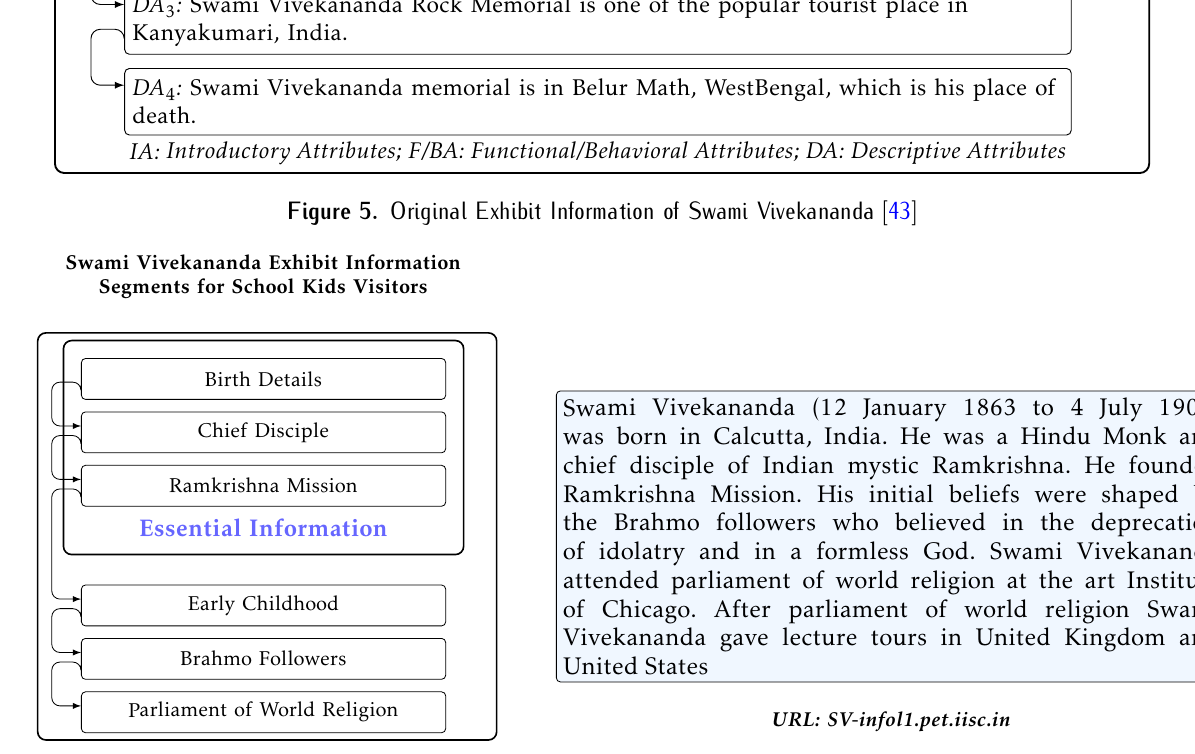
Figure 6. Organized Exhibit Information of Swami Vivekananda at URL: SV-infol1.pet.iisc.in for School Kid Ubiquitous